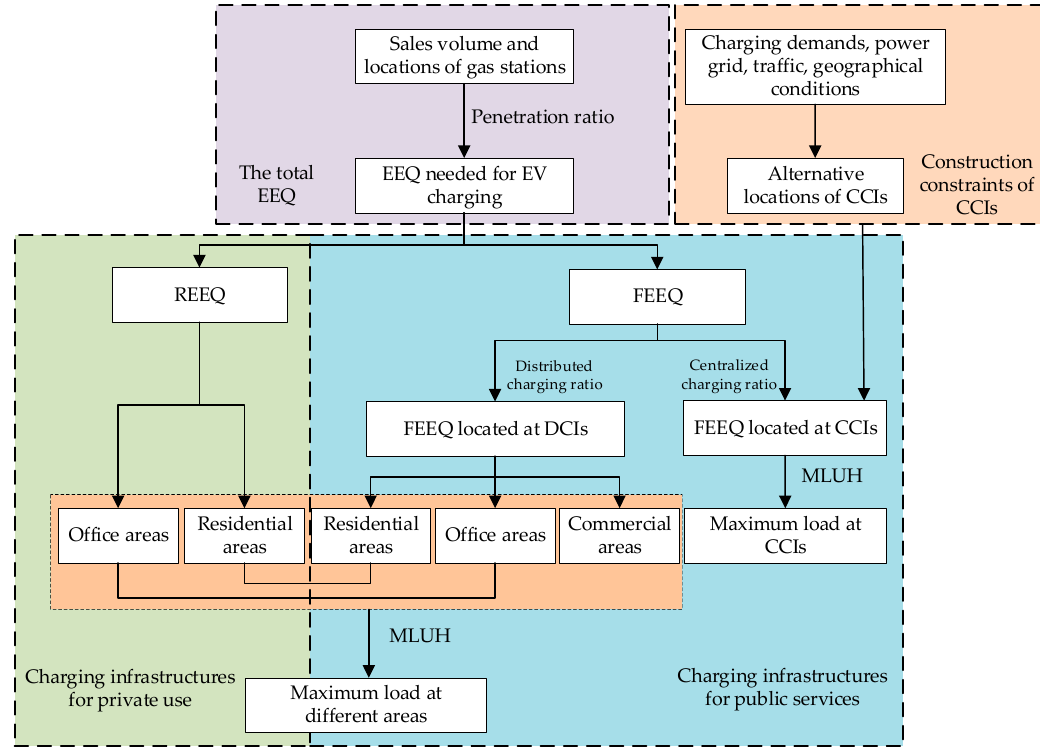
Figure 2. The block diagram of load forecasting based on energy equivalence.